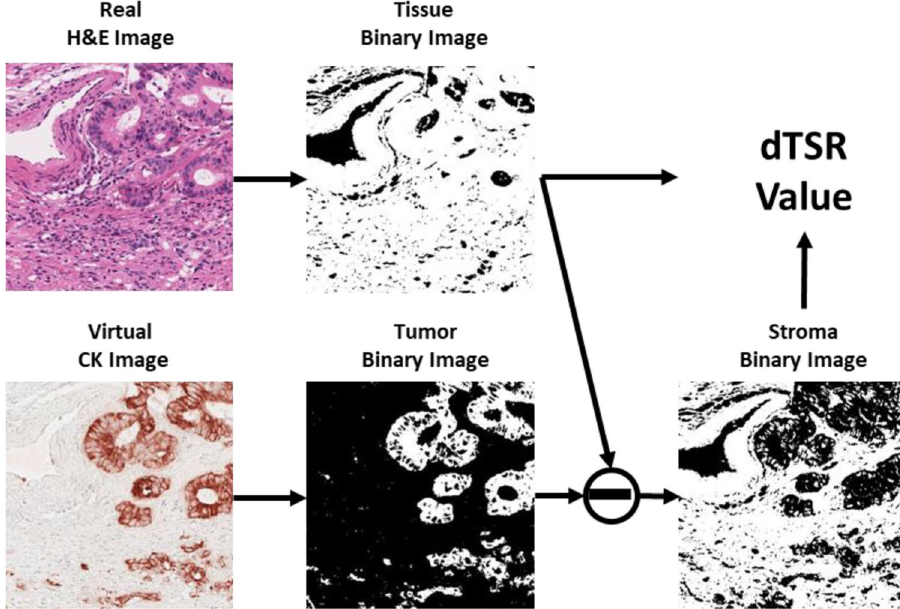
Figure 3. The dTSR scoring process. The white region on the binary image indicates the corresponding detected region of tissue, tumor, and